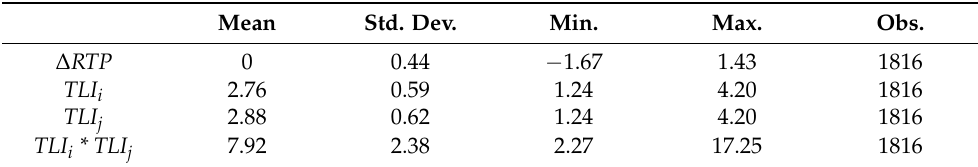
Table 10. Summary statistics of the variables used in Equation (6).